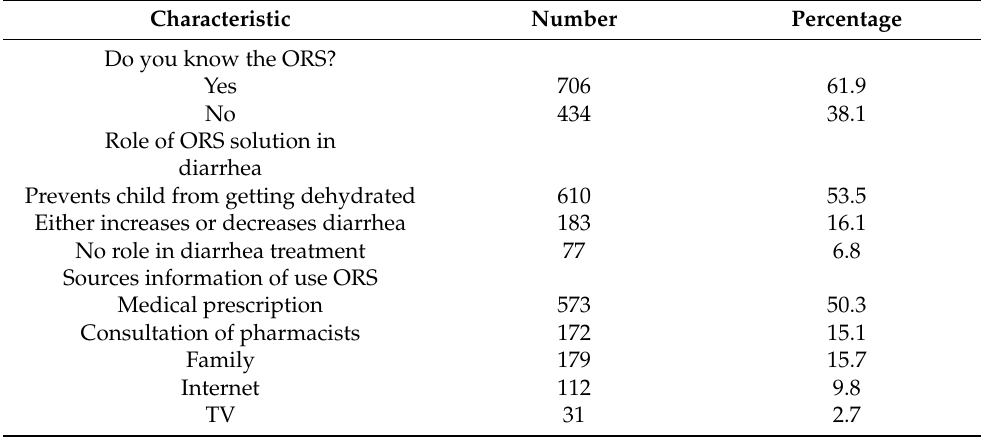
Table 3. Mothers’ knowledge about the use of ORS.